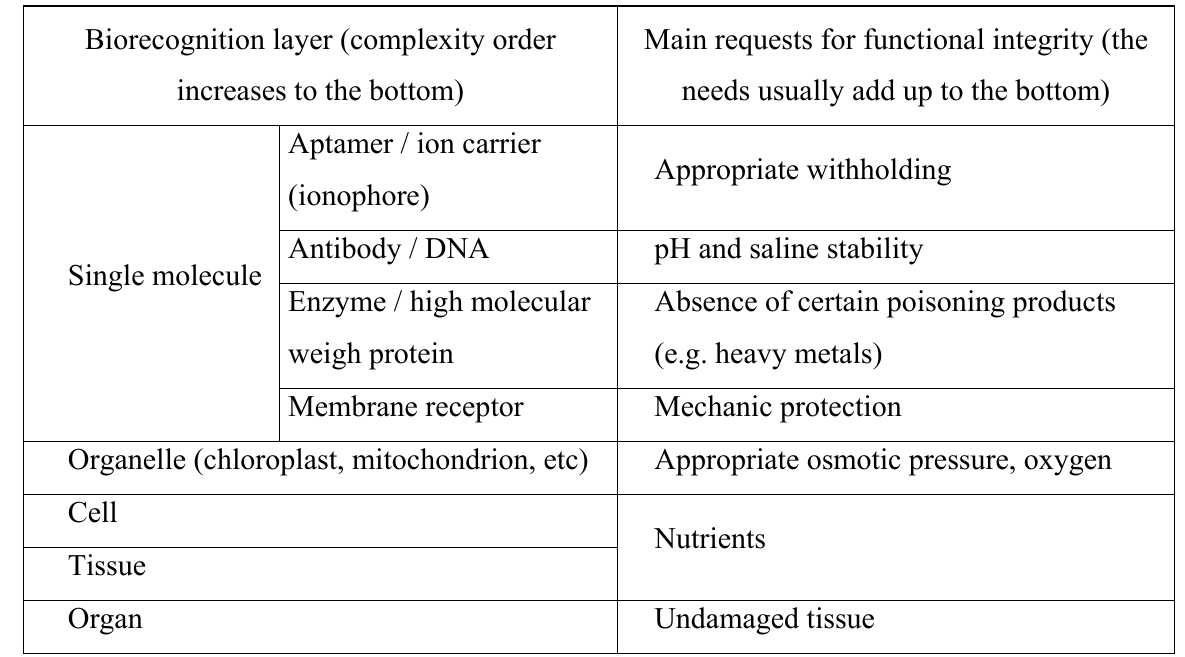
Table 1. Most important requirements to preserve the bioreceptor